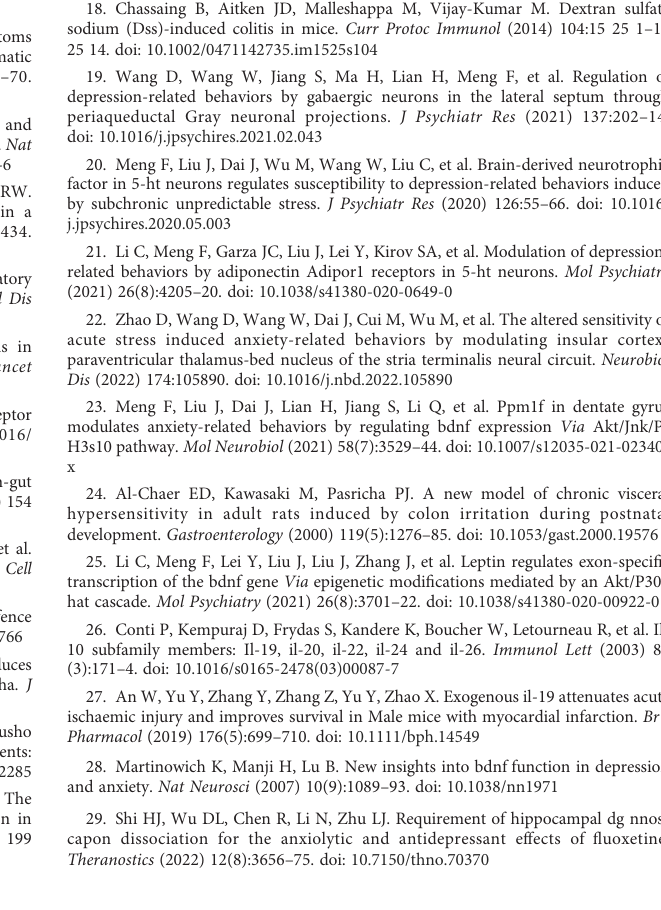
patients. Control group: n=44, IBD group: n=32. ** p < 0.01, compared to the control group. SUPPLEMENTARY FIGURE 2 Depression/anxiety-related behaviors and colitis induced by chronic DSS (three days) application. (A) Schematic diagram of experimental designs. (B) Sucrose preference test (SPT). (C) Elevated plus-maze test (EPM). (D) Light- dark(LD). (E) Open- fi eldtest(OFT). (F) Locomotoractivity. (G) DiseaseActivity Index (DAI). (H) Visceral sensitivity (VS). (I) Colonic length (CL). H 2 O group: n= 7, DSS group: n=8. * p < 0.05, ** p < 0.01, *** p < 0.001, compared to the control group. SUPPLEMENTARY FIGURE 3 The correlation analysis of colonic length with depression/anxiety-related behaviors in the chronic DSS (three days) treated mice. (A) Visceral sensitivity (VS)/SPT. (B) Visceral sensitivity (VS)/EPM. (C) Visceral sensitivity (VS)/LD. (D) Visceral sensitivity (VS)/OFT. n=11. SUPPLEMENTARY FIGURE 4 The correlation analysis of colonic length with depression/anxiety-related behaviors in the chronic DSS (three days) treated mice. (A) Colonic length (CL)/SPT. (B) Coloniclength(CL)/EPM. (C) Coloniclength(CL)/LD.(D)Colonic length (CL)/OFT.